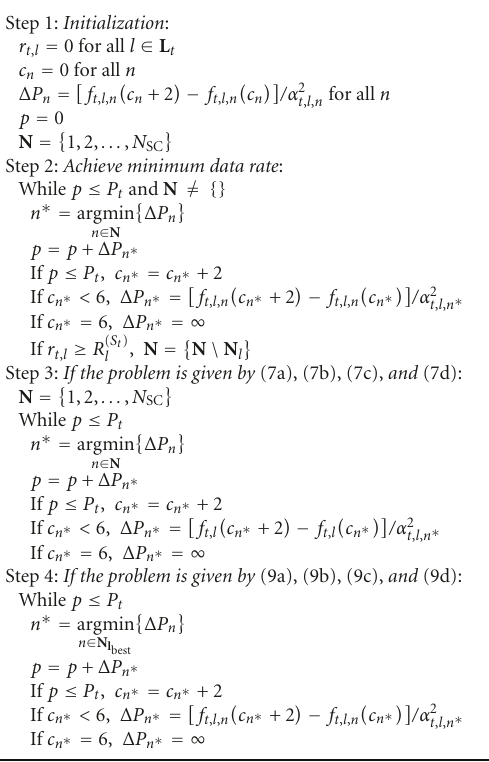
Figure 3: Bit and power loading algorithm.